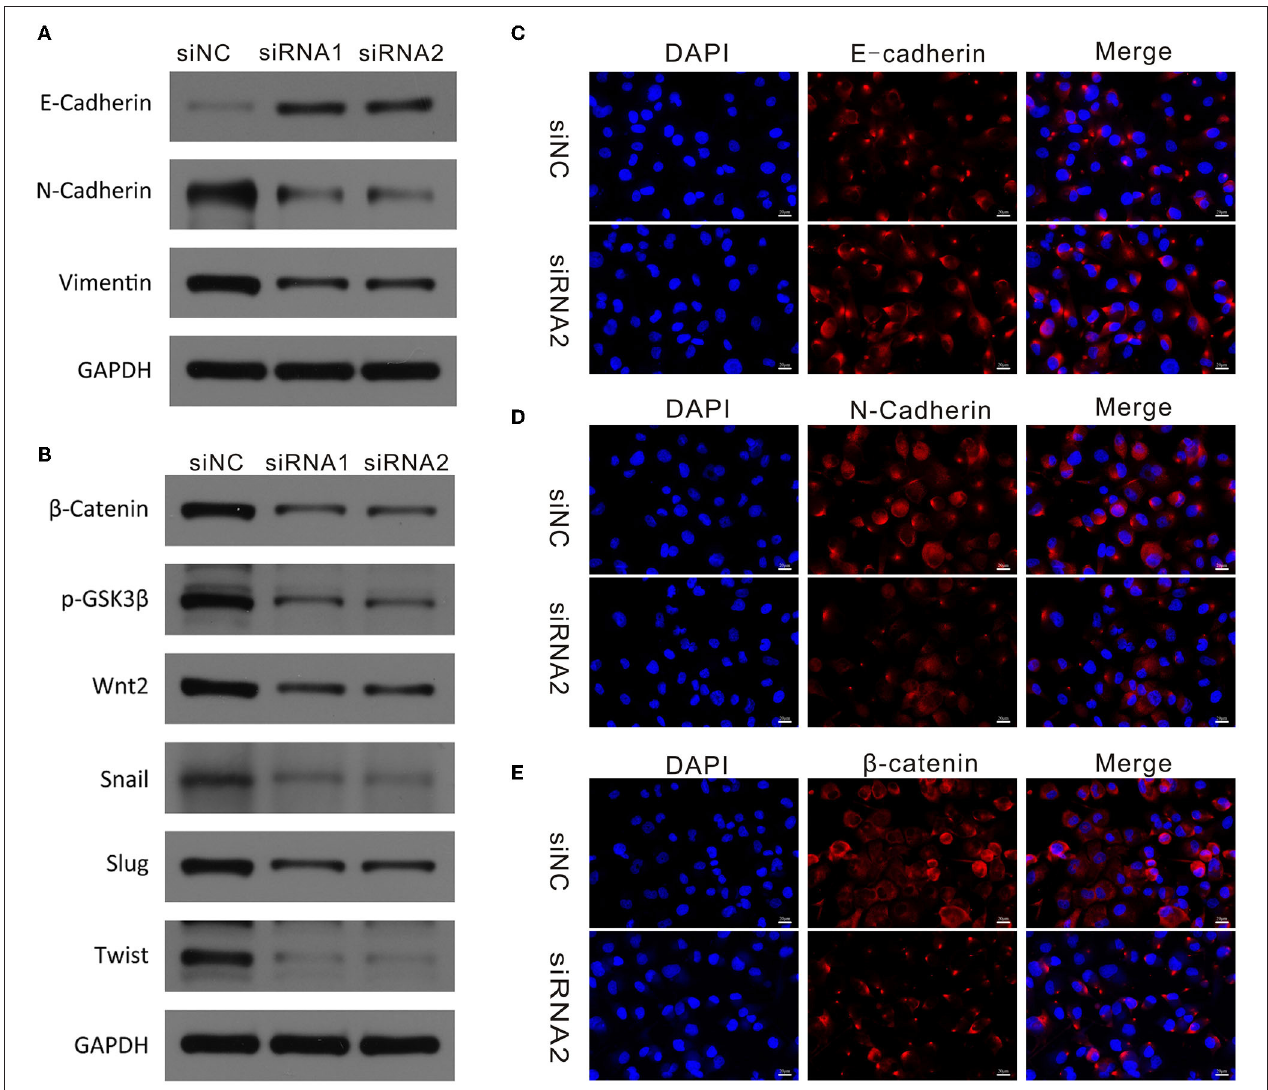
FIGURE 7 | CAPN2 regulates EMT markers and the Wnt/ β -catenin pathway in PC. (A) Western blot analysis shows reduced N-cadherin and vimentin and increased E-cadherin expression in CAPN2-silenced Panc-1 cells and SW1990 cells compared with that in control cells. (B) Western blot analysis shows reduced levels of β -catenin, Wnt2, p-GSK-3 β , Snail1, Slug, and TWIST in CAPN2-silenced Panc-1 cells and SW1990 cells compared with that in control cells. (C–E) Immunofluorescence staining of E-cadherin, N-cadherin and β -catenin in CAPN2-silenced Panc-1 cells compared with that in control cells.